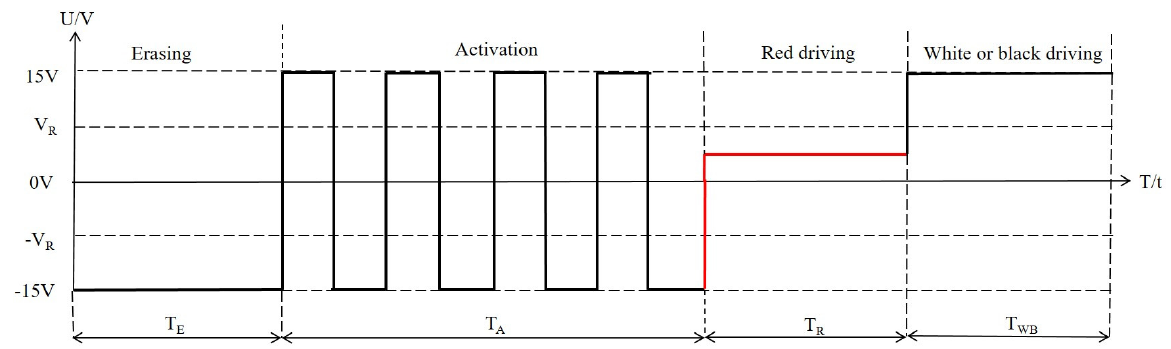
Figure 3. The traditional driving waveform of three-color EPDs. It was composed of an erasing stage, an activation stage, a red driving stage, and a white or a black driving stage. T E is the driving time of the erasing stage, T A is the driving time of the activation stage, T R is the driving time of the red driving stage, T WB is the driving time of the white or the black driving stage. V R is the driving voltage of red